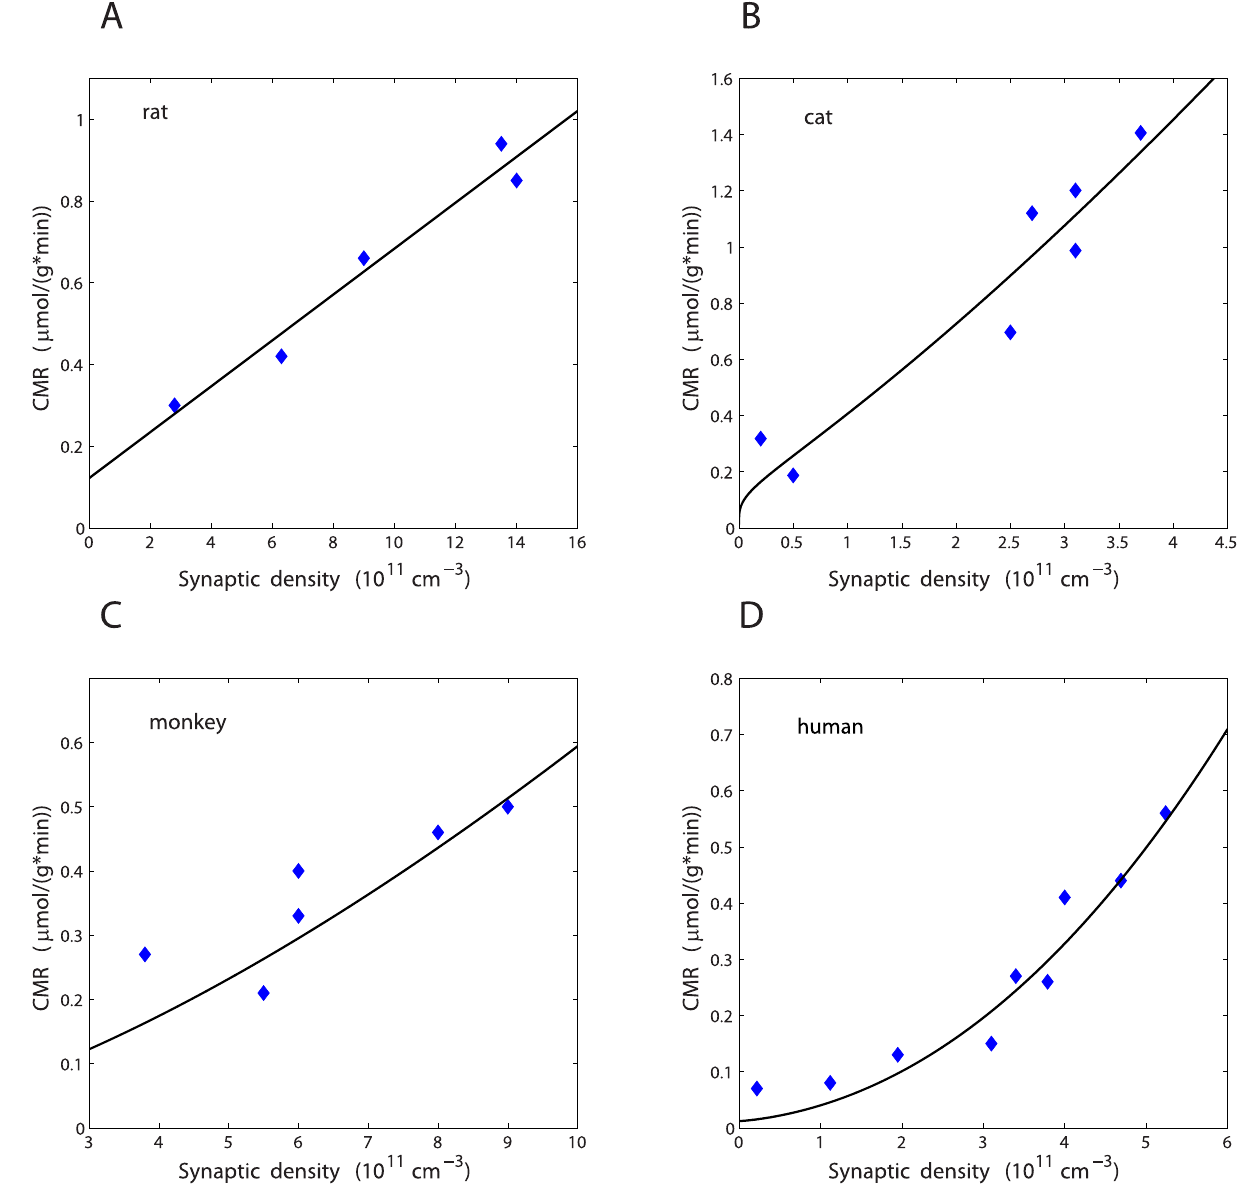
Figure 3. Empirical dependence of cerebral metabolic rate CMR on synaptic density r s together with fits to the theoretical metabolic model. (A) Rat, parietal cortex. (B) Cat, visual cortex. (C) Monkey, visual cortex. (D) Human, frontal cortex. Empirical data are represented by diamonds, and theoretical fits by solid lines. The fitting parameters are shown in Table 4.